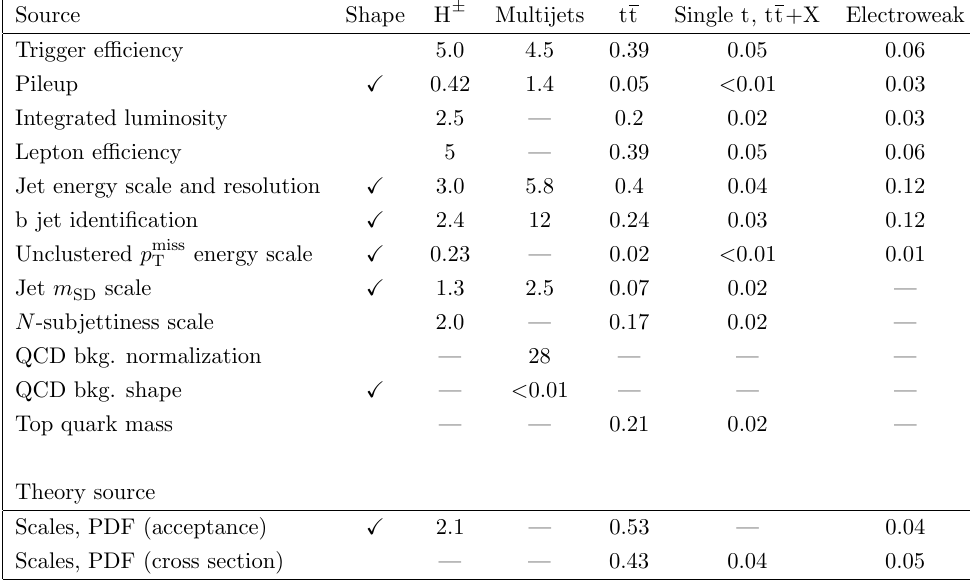
The systematic uncertainties a(cid:11)ecting signal and background for the boosted analysis, evaluated after (cid:12)tting to data, summed over all (cid:12)nal states and categories. The numbers are given in percentage and describe the e(cid:11)ect of each nuisance parameter on the overall normalization of the signal model or the total background. Nuisance parameters with a check mark also a(cid:11)ect the shape of the H spectrum. Sources that do not apply in a given process are marked with dashes. T For the H (cid:6) signal, the values for m = 1 TeV and for associated production are shown. H (cid:6)